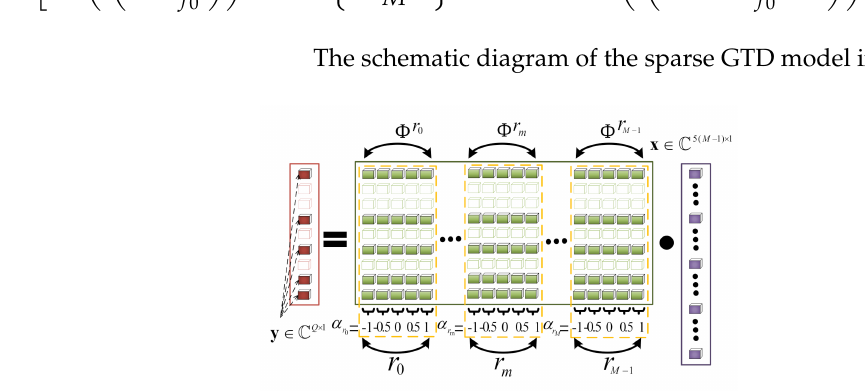
Figure 2. Diagram of the sparse GTD